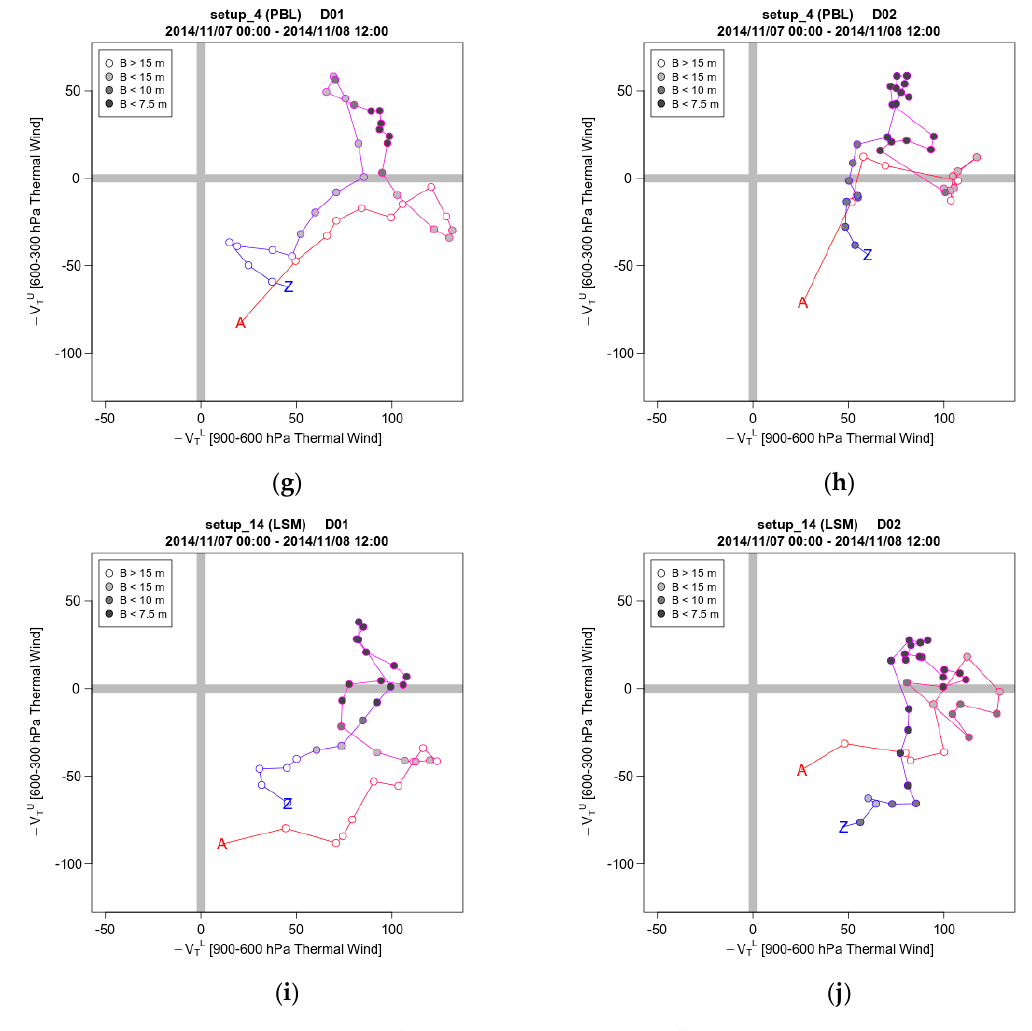
Figure 8. Phase space diagrams of − V TL (900–600 hPa) against − V TU (600–300 hPa) as predicted from model PBL / LSM experiments in D01 for: ( a ) setup_1, ( c ) setup_2, ( e ) setup_3, ( g ) setup_4, ( i ) setup_14 and in D02 for: ( b ) setup_1, ( d ) setup_2, ( f ) setup_3, ( h ) setup_4, ( j ) setup_14. Symmetry B is denoted by the shade of circles.